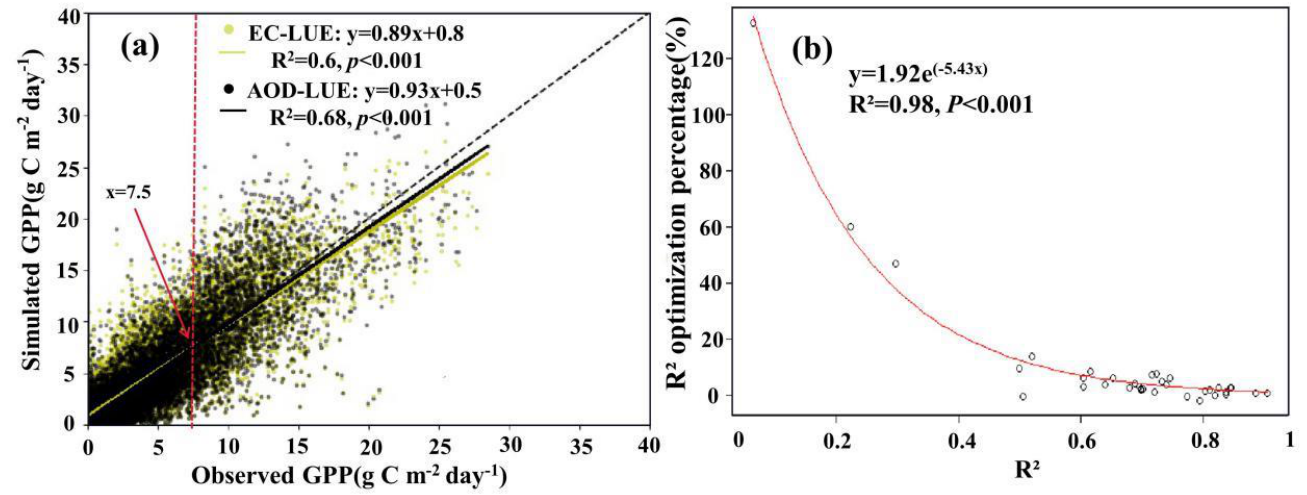
8 of 17 Figure 4. Scatter plot of daily diffuse fraction (D f ) and daily AOD of flux tower sites globally. The red line is fitted by the Michaelis – Menten equation in clear sky. V max represents the maximum D f , and K m represents the AOD value at half of the maximum D f . 3.3. Improvement of GPP Estimation by Considering the Aerosol - Radiation Effect Compared with the EC-LUE model, the improved GPP model that considered aero- sol-radiation effects (i.e., the AOD-LUE model) can more accurately estimate GPP (Figure 5a). The AOD-LUE model had higher R² (0.68) and slope (0.93) than the EC-LUE model (R 2 = 0.6 and slope = 0.89). The data points of the AOD-LUE model values were more concentrated in the vicinity of the 1:1 line than those of the EC-LUE model, which indi- cated that the GPP values estimated by the AOD-LUE model were closer to the true values (i.e., flux tower GPP). Additionally, the simulated value of the AOD-LUE model de-